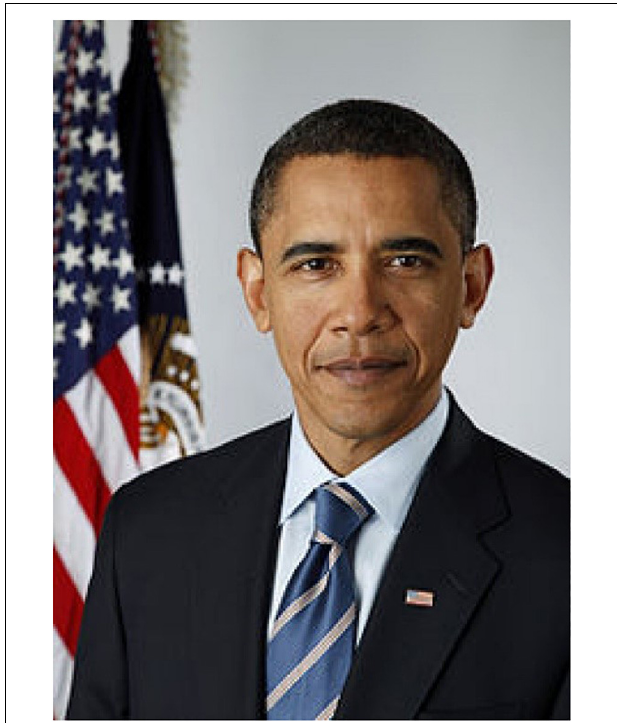
FIGURE 1 | Neutral facial expression accompanying the speech excerpt in the control condition. Image licensed under Creative Common Attribution 3.0 License. Photographed and attributed to Pete Souza. Available via https://it.wikinews.org/wiki/File:Official_portrait_of_Barack_Obama.jpg.